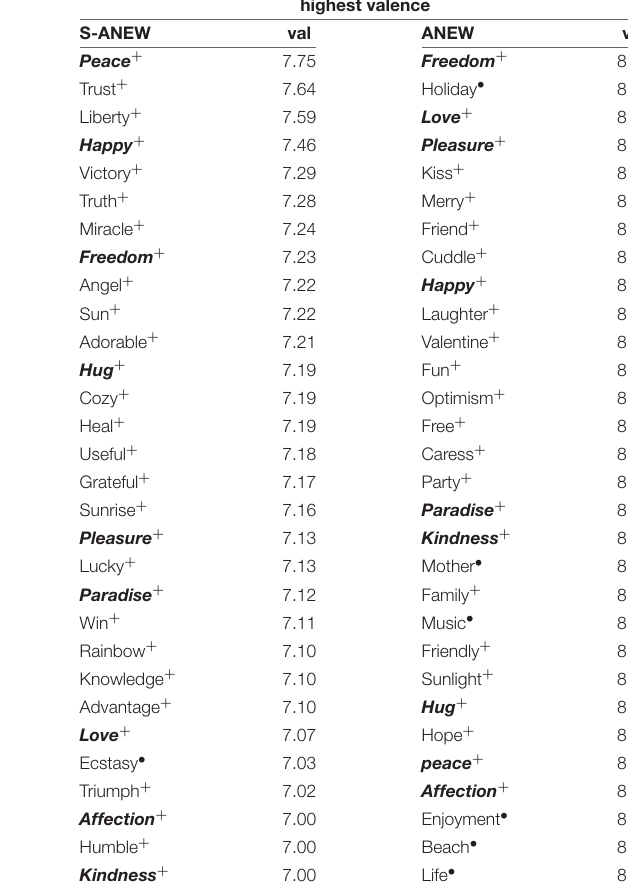
TABLE 3 | The thirty lowest (left) and highest (right) valence rated words. Lowest valence highest